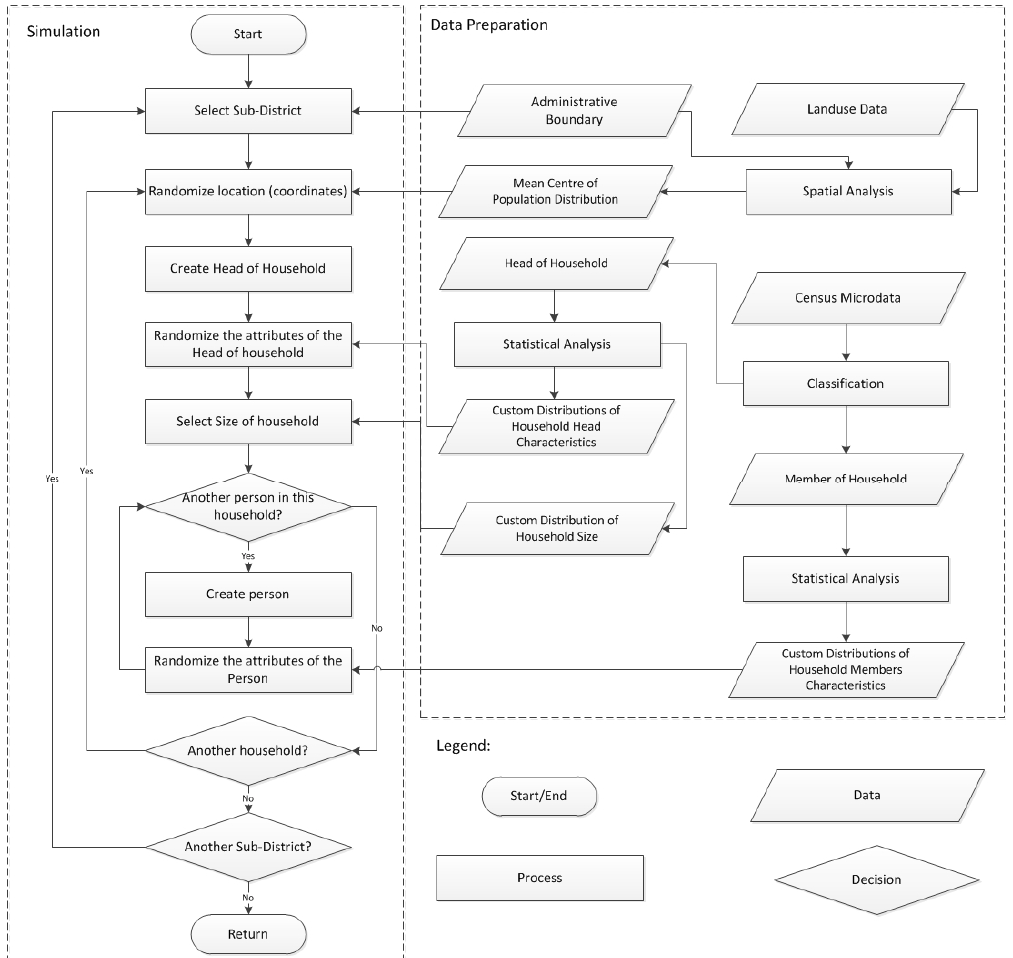
Figure 4. Synthetic population generation. Table 6. Real population level (2010) and simulated agents.